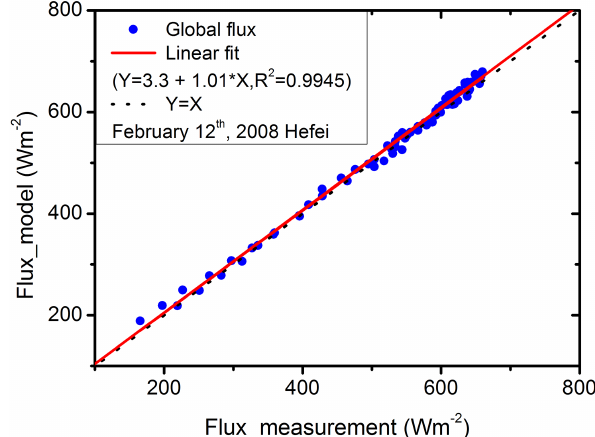
Figure 6. The same as Fig. 3 but in 12 February